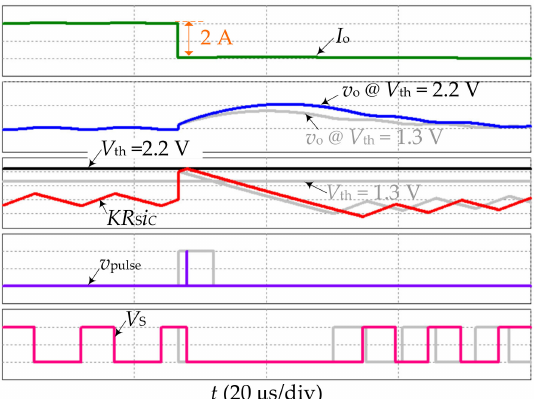
Figure 10. Simulation waveforms for improved CC-COT-controlled buck converter with V th = 2.2 V.